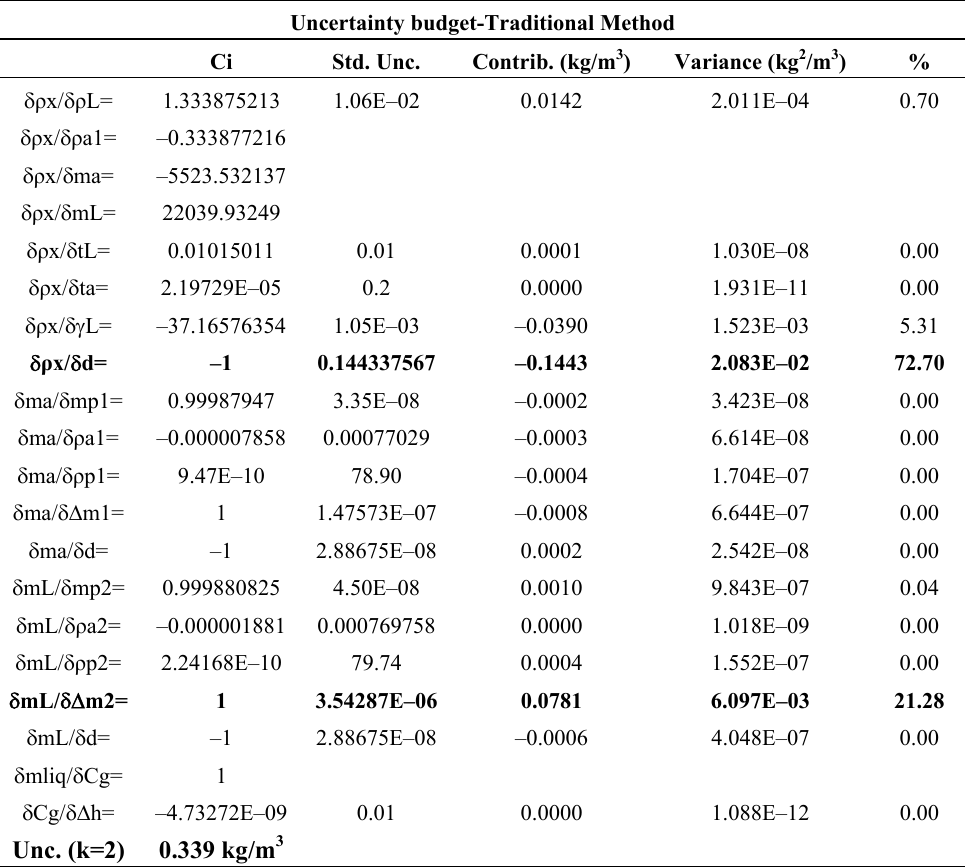
Table 12. Uncertainty budget − Traditional method − d = 0.5 kg/m 3